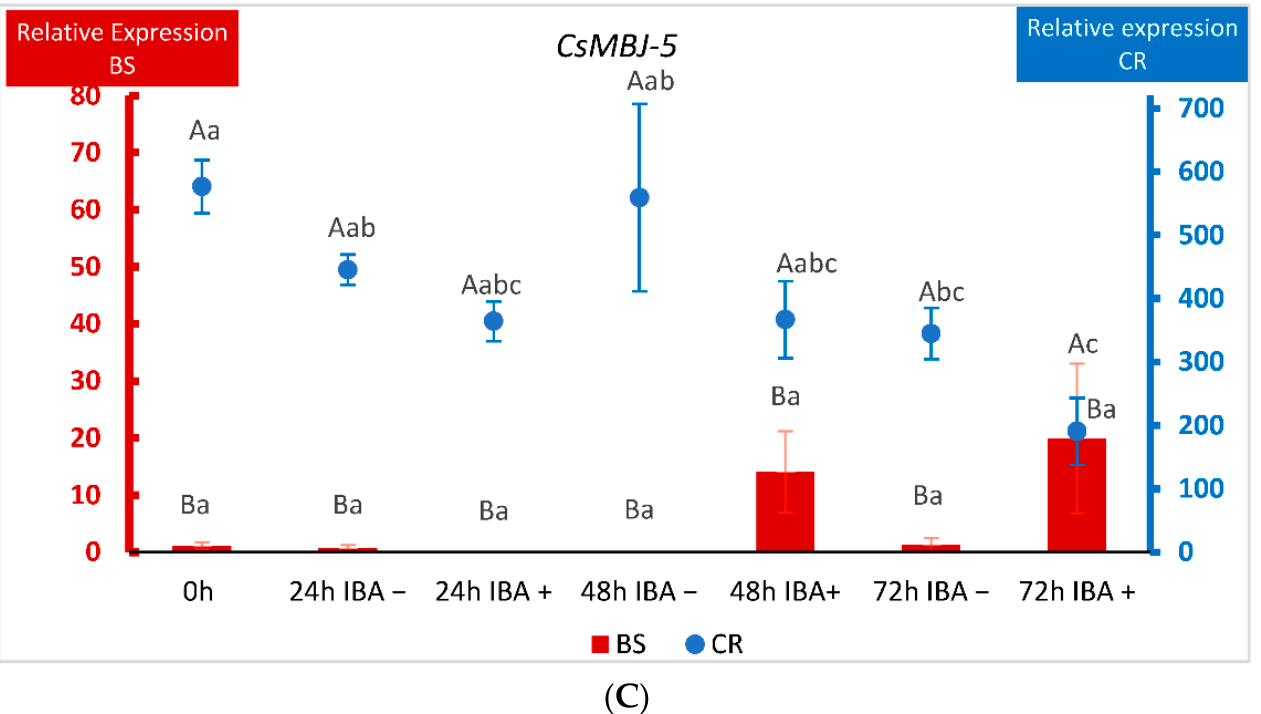
Figure 6. qPCR analysis of the expression of three MADS-box genes in chestnut tissues. ( A ) Expression of the CsMADS-box SVP-2 gene ( MBS2 ) in BS (Juvenile) samples and CR (Mature) samples. ( B ) Expression of the CsMADS-box Jointless-3 gene ( MBJ3 ) in BS (Juvenile) samples and CR (Mature) samples. ( C ) Expression of the CsMADS-box Jointless-5 gene ( MBJ5 ) in BS (Juvenile) samples and CR (Mature) samples. Data correspond to mean ± standard error. 0 h: samples collected at the end of the multiplication cycle and prior to any treatment. Samples were wounded ( − ) or wounded and treated with IBA (+) and collected at the indicated times (in hours). Due to the differences in magnitude between juvenile and mature lines, BS and CR relative expressions were displayed on different Y-axes. The data were subjected to two-way analysis of variance (ANOVA), followed by the comparison of group means (Tukey-b test), or to the Welch ANOVA, followed by Games–Howell post-hoc comparison (when heteroscedasticity was detected). Different capital letters indicate significant differences ( p < 0.05) in relation to the line, and different lowercase letters indicate significant differences in relation to the treatment. Due to the significant interaction found in genes CsMBS-2 and CsMBJ-5 , Bonferroni’s adjustment was applied to detect simple main